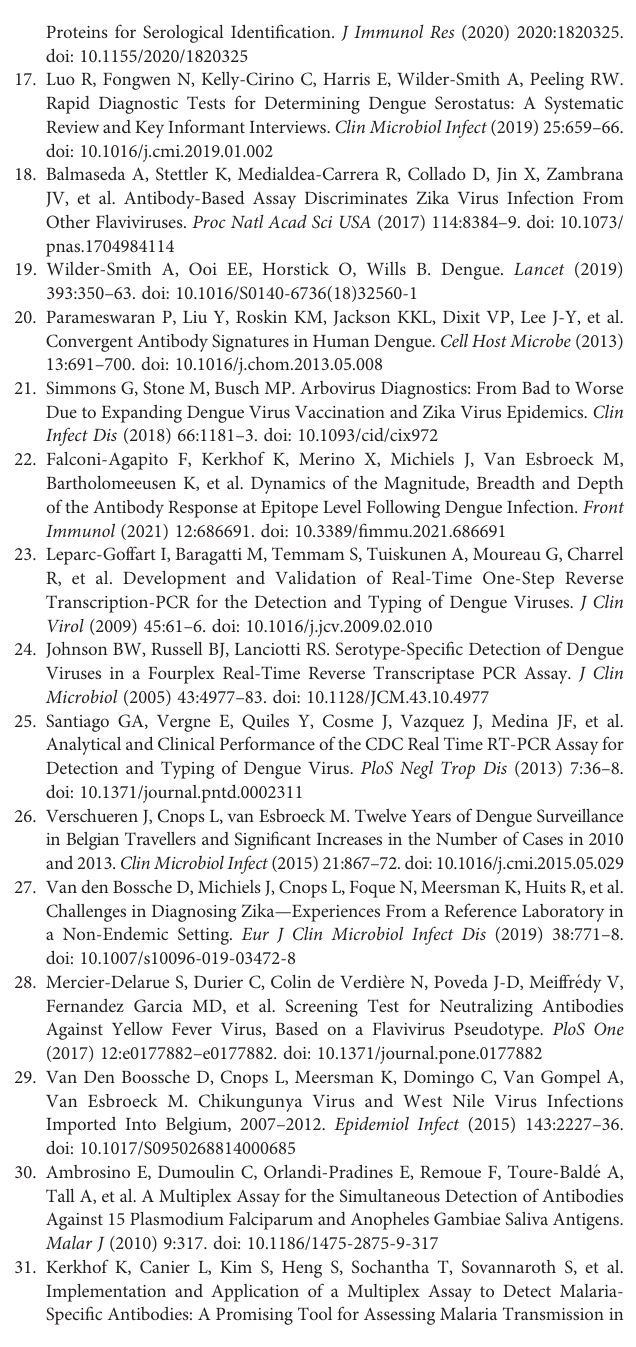
coef fi cients are indicating by the color scale. Blue indicates a negative correlation; red indicates a positive correlation. (B) Pairwise correlation between each IgM peptide and the commercial DENV ELISA IgM kit. (C) Pairwise correlation between each IgG peptide and the commercial DENV ELISA IgG kit. The antibody response was measured in MFI for the synthetic peptides and OD(Absorbance at 450 nm)for the commercial kit. Each dot represents a sample. Dashed red lines indicate the cut-off values for the commercial kit according the manufacturer instructions (vertical line) and for the peptide based on the ROC curves enforcing a minimum speci fi city of 80% (horizontal line).